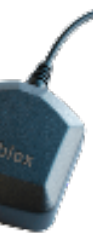
Fig. 4. Ublox ANN-MS